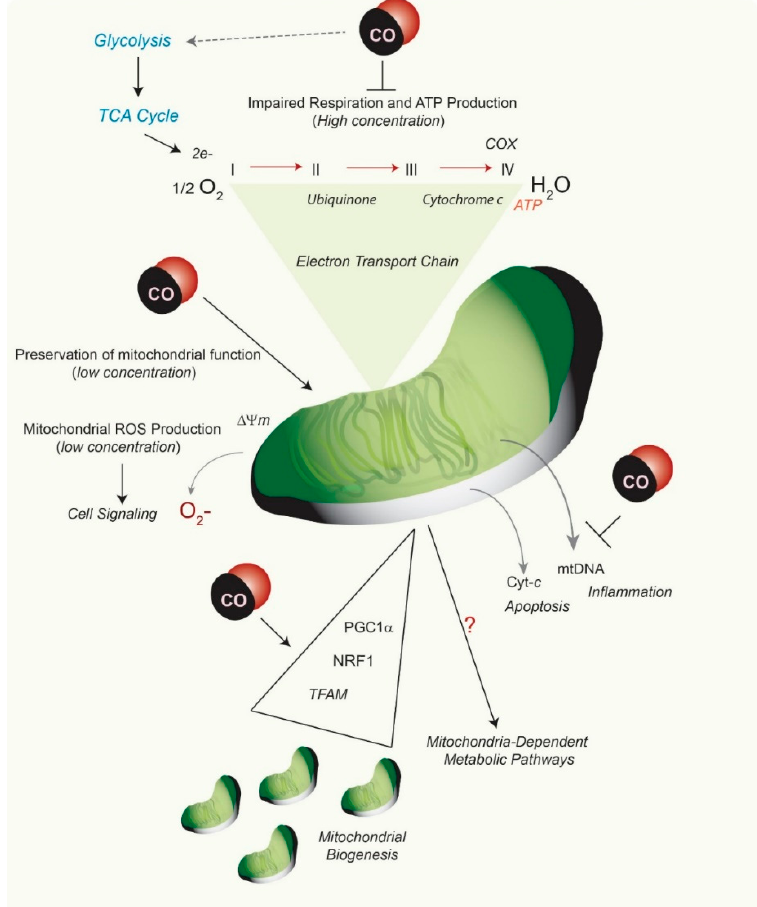
Figure 3. Mitochondria as a target of CO action . CO has been shown to preserve mitochondrial function at low concentration, including preservation of mitochondrial membrane potential which can be disrupted by pro-inflammatory stimuli [63]. Stimulation of various cell types with CO can modulate mitochondrial ROS (mtROS) production, in a cell type specific and context-specific manner [63,73–78]. CO can also modulate the activity of mitochondrial hemoproteins, including cytochrome c oxidase (COX). At high concentration CO can inhibit mitochondrial respiration, inhibit mitochondrial energy (ATP) production [71], and also modulate the glycolytic pathway in a dose-dependent manner [80,81]. CO has been implicated in several cellular e ff ects, which include the modulation of apoptosis [65,66] and (inflammasome-dependent) inflammation [63,64], that are mediated by mitochondria-derived soluble factors, including cytochrome-c (Cyt- c ) and mitochondrial DNA (mtDNA), respectively. Finally, CO has been shown to act as a potent modulator of mitochondrial dynamics and biogenesis in various studies [82–88]. These e ff ects were contingent on the upregulation of regulatory factors: PPAR- γ coactivator-1 α (PGC-1 α ), nuclear respiratory factor 1 (NRF1), and mitochondrial transcription factor A (TFAM) [87].